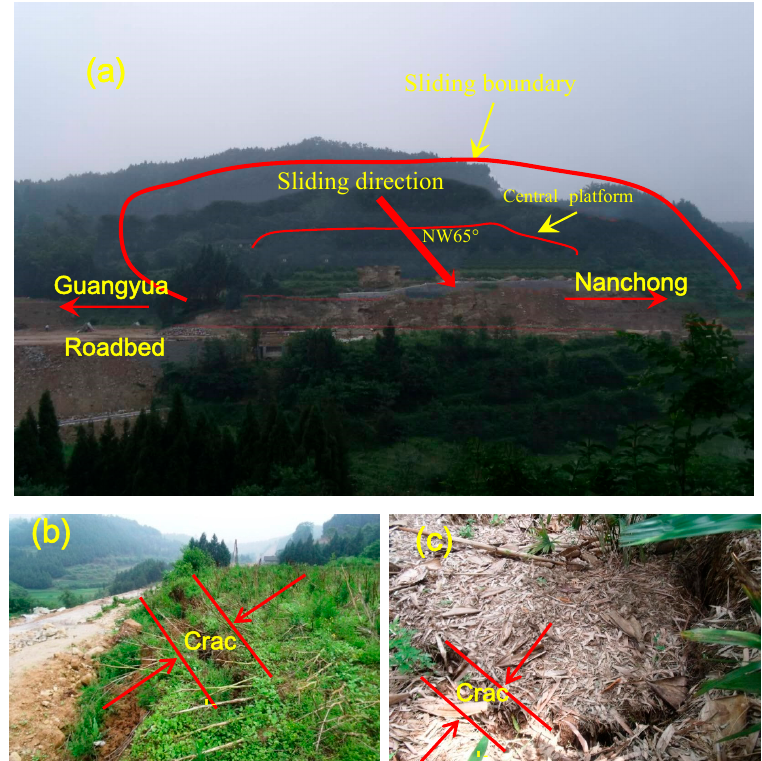
Figure 3. Yanzishan landslide and slope deformation: ( a ) The range of the Yanzishan landslide; ( b ) cracking observed at the front edge of the slope; and ( c ) cracking in the middle of the slope.